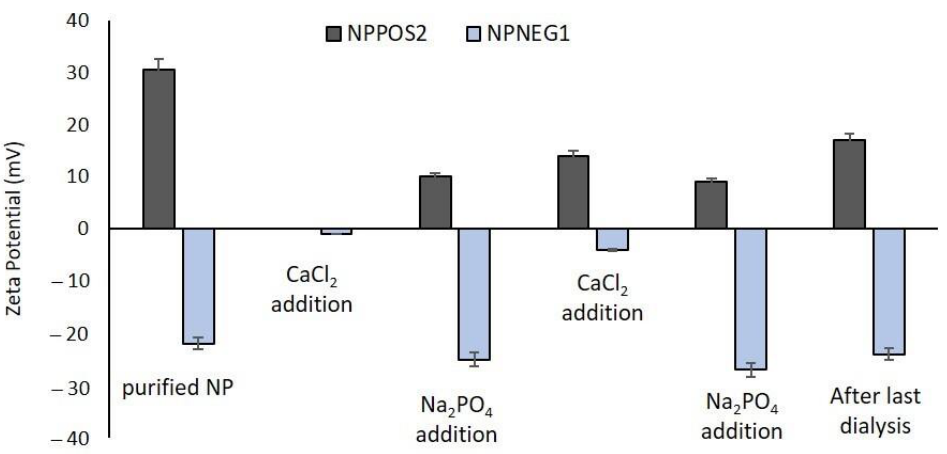
Figure 3. Variation of Zeta potential during coating process via method B.